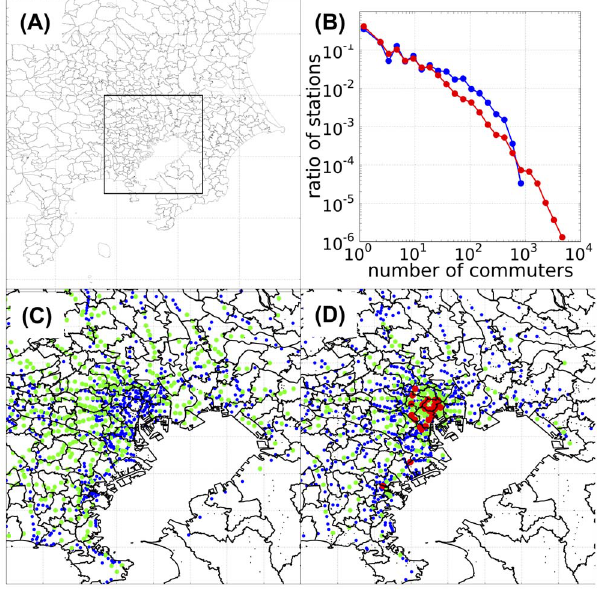
Figure 1. Commuter flow data for the Tokyo metropolitan area. (A) Geographical location of the Tokyo metropolitan area within Kanto region, Japan. The framed rectangle shows the central part of the Tokyo metropolitan area. (B) Distribution of the station sizes on a double- logarithmic plot. Blue line, distribution of home-node stations; red line, distribution of work-node stations. (C) and (D) Geographical distribu- tions of the sizes of home- and work-node stations, respectively, within the central part of the Tokyo metropolitan area. The color indicates the size of the station: black, 0 * 10 commuters; blue, 10 * 100 commuters; green, 100 * 1,000 commuters; red, 1,000 * commuters. All numbers are from the 139,841 collected questionnaires of UTC. The red-colored stations in the middle of (D) correspond to Tokyo’s inner urban area (along the loop of the Yamanote line); the 2 red stations in the lower left of (D) are the Kawasaki and Yokohama stations. The longitude and latitude of each station were acquired from the Station Database